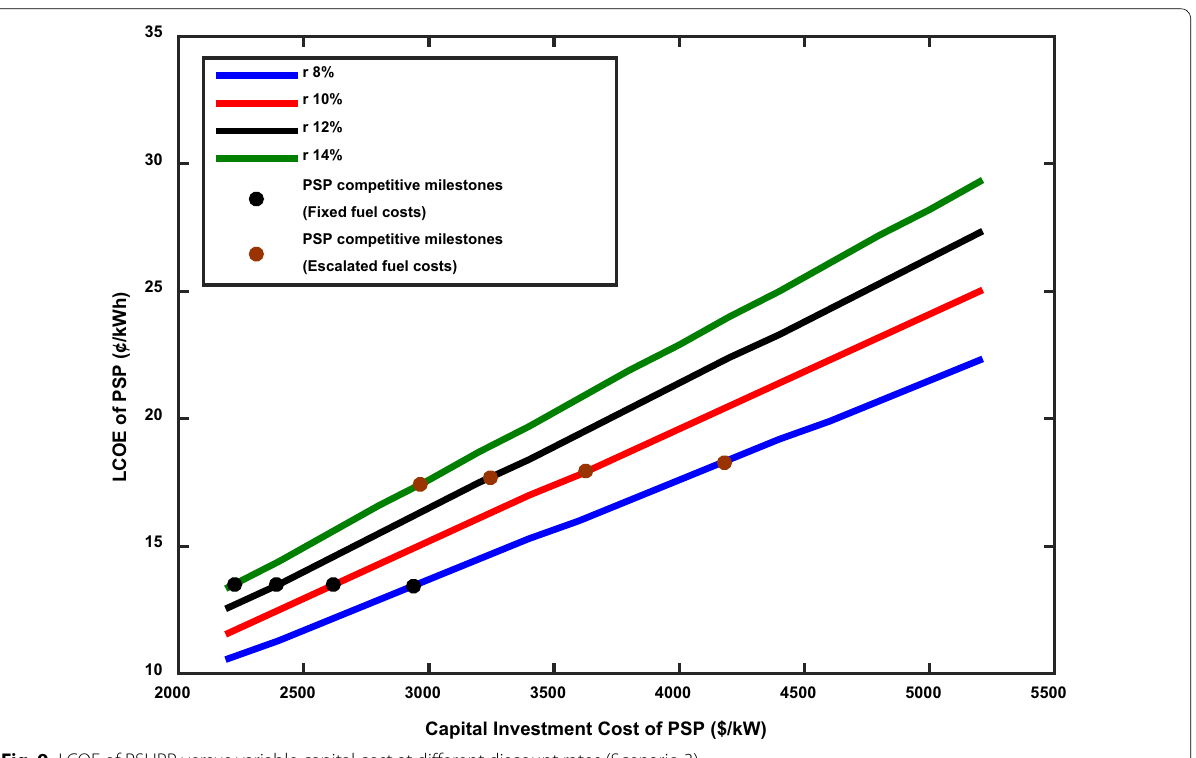
Fig. 9 LCOE of PSHPP versus variable capital cost at different discount rates (Scenario